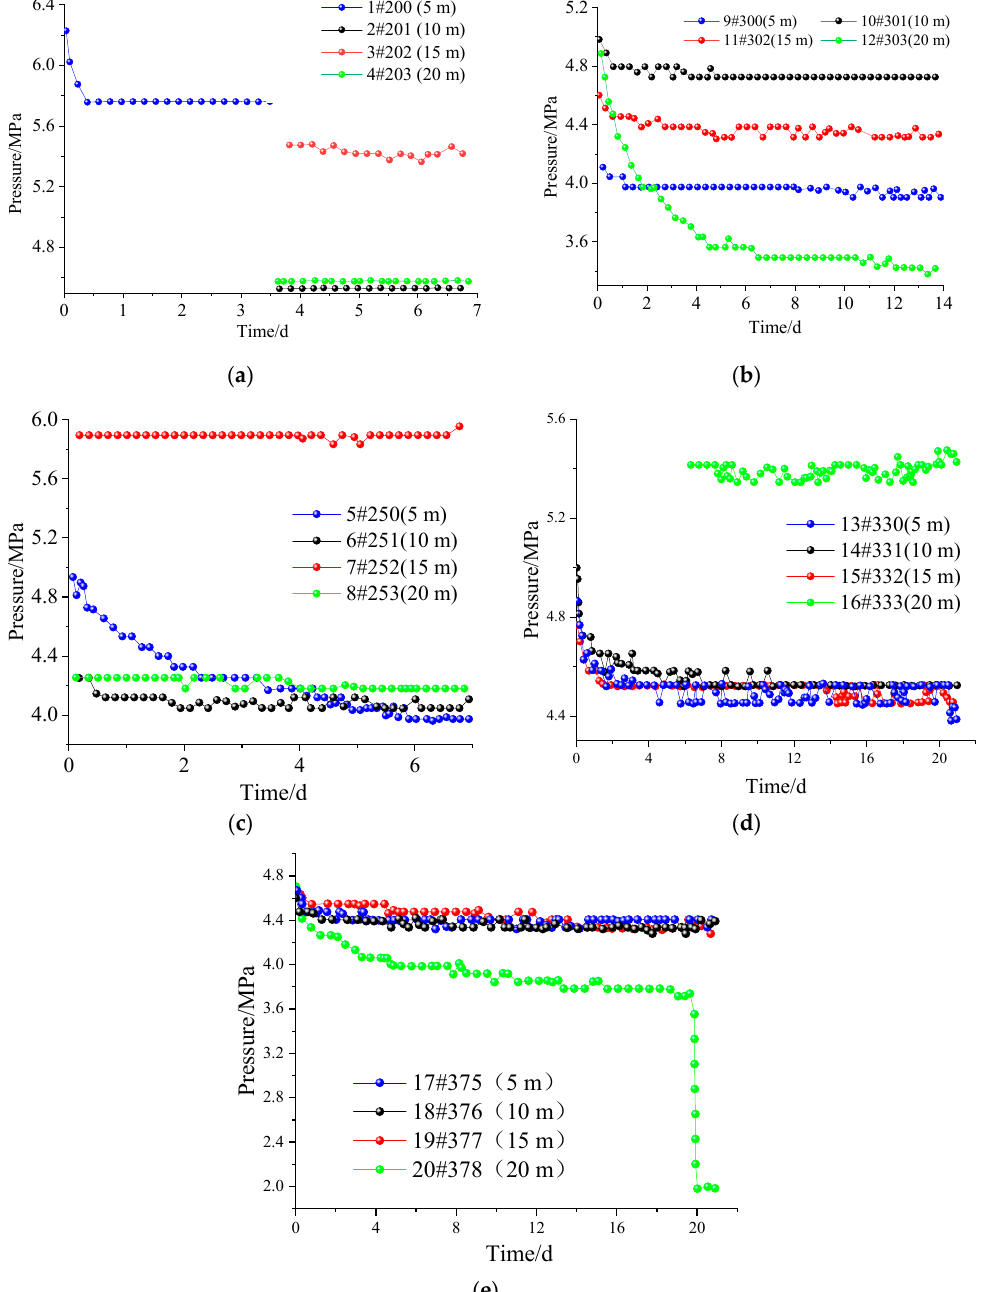
Figure 6. Stress monitoring diagram. ( a ) The first station; ( b ) The second station; ( c ) The third station; ( d ) The fourth station; ( e ) The fifth